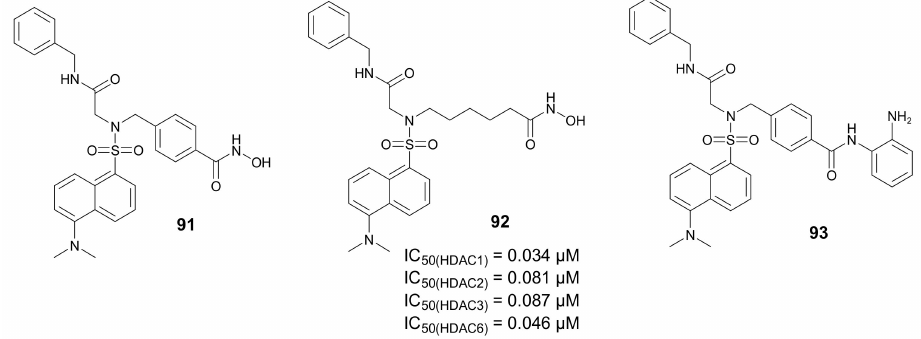
Figure 31. Chemical structures of compounds 91 – 93 .